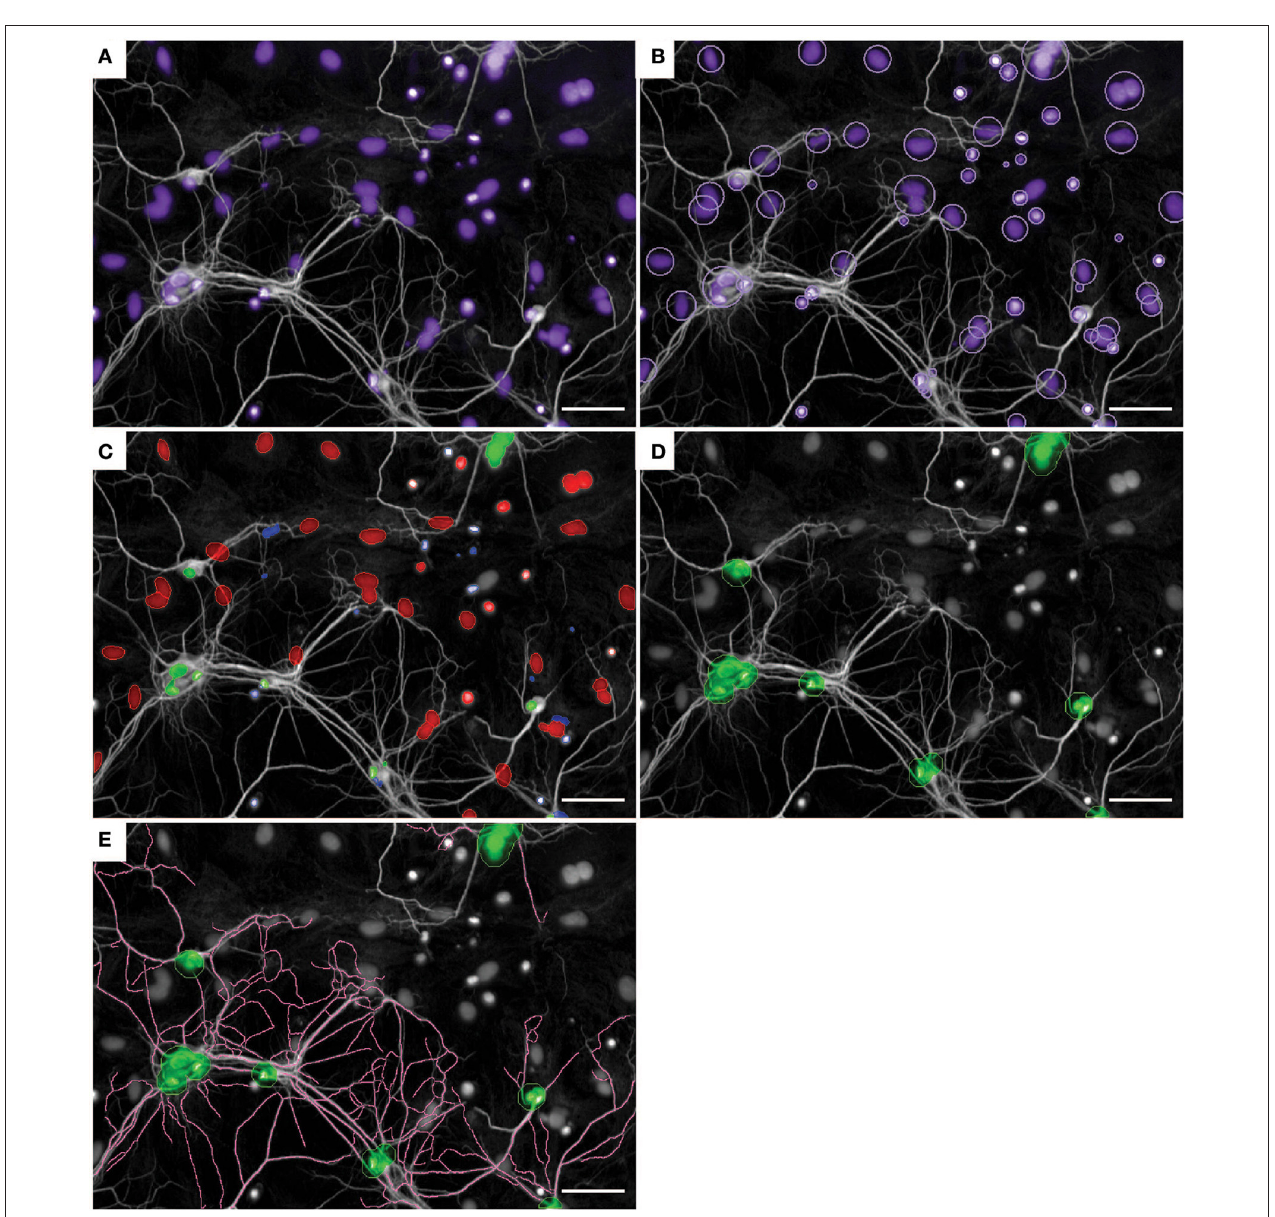
FIGURE 2 | Nuclei and neurite detection in primary neuron-astrocyte co-cultures using Columbus software. (A) Input example image of co-culture in serum-free medium without supplementation. In white: MAP2-postive neurites, in purple: Hoechst-positive nuclei. (B) Nuclei detection based on Hoechst intensity. (C) Nuclei were categorized into three cell types: neurons (green), astrocytes (red), remaining cells (blue). (D) Neuronal nuclei are resized to improve neurite detection. (E) Neurite detection starting from resized neuronal nuclei. Images were taken with a 20x objective. Scale bar represents 50 µ